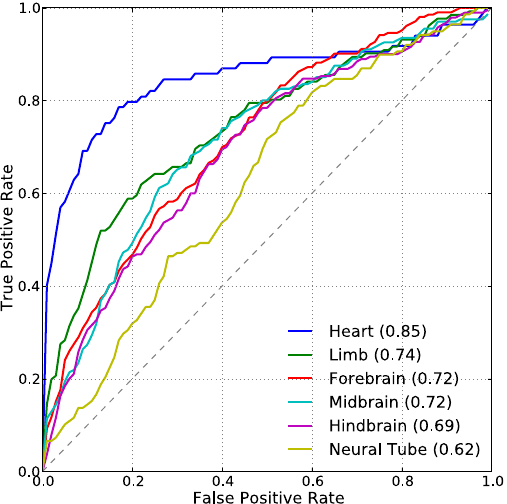
Figure 4. Enhancers of heart expression are easier to identify than enhancers active in other tissues at E11.5. (A) In Step 2 of our prediction pipeline, we trained EnhancerFinder using the same features as in Step 1 (Figure 1), but using VISTA enhancers active in a given tissue as positives and tested regions that did not show activity in the tissue as negatives. Heart enhancers were dramatically easier to distinguish from other enhancers than enhancers of expression in other tissues. The heart enhancers have significantly higher GC content than other enhancers and the genomic background. This and several other unique attributes may explain the ease of identifying them (Figures S7 and S8). In general, functional genomics data are the most informative data type for predicting enhancer tissue specificity (Table